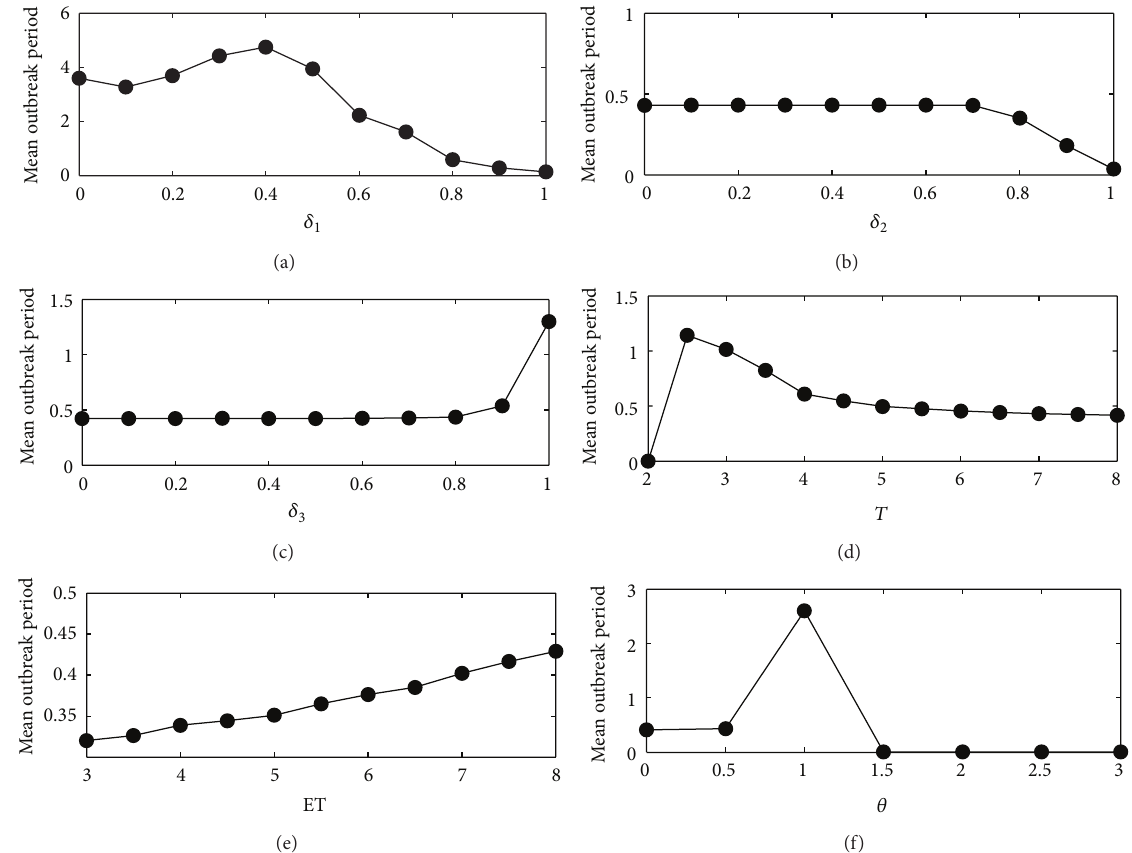
Figure 9: The relationship between mean outbreak period and the parameters 𝛿 1 , 𝛿 2 , 𝛿 3 , 𝑇 , ET, and 𝜃 of model (11). The other parameters are the same as Figure